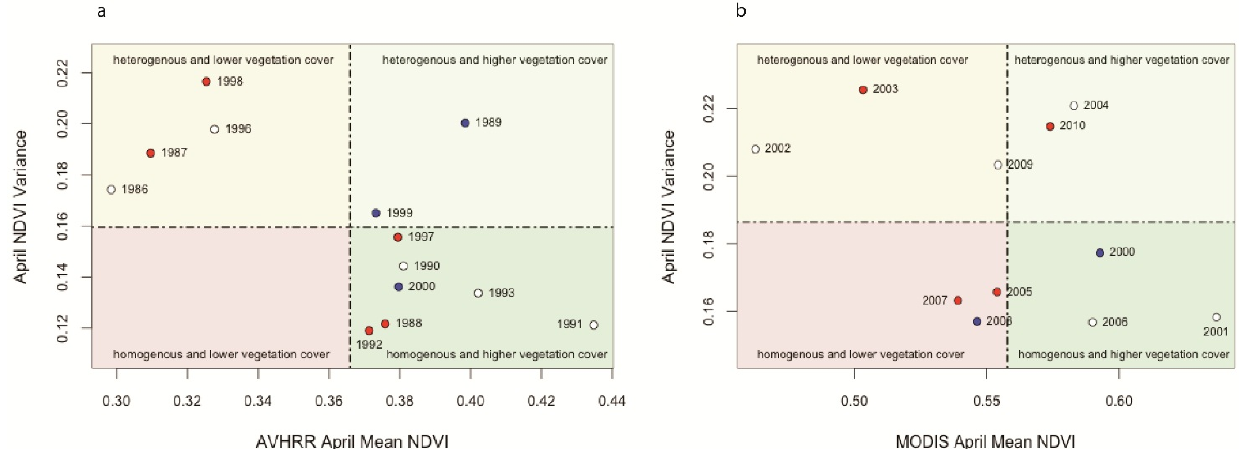
Figure 6. ( a ) Mean-variance plot of AVHRR April MVC NDVI data from 1985 to 2000 and ( b ) Mean-variance plot of MODIS April MVC NDVI data from 2000 through 2010 for Chobe River Basin. Red symbols represent warm ENSO phase years, blue symbols indicate cold ENSO phase years, and white symbols—neutral ENSO phase years. The dotted lines in both graphs indicate the long-term mean MVC NDVI value and mean variance, respectively, and are used to create the four vegetation dynamics sectors proposed by Washington-Allen et al.